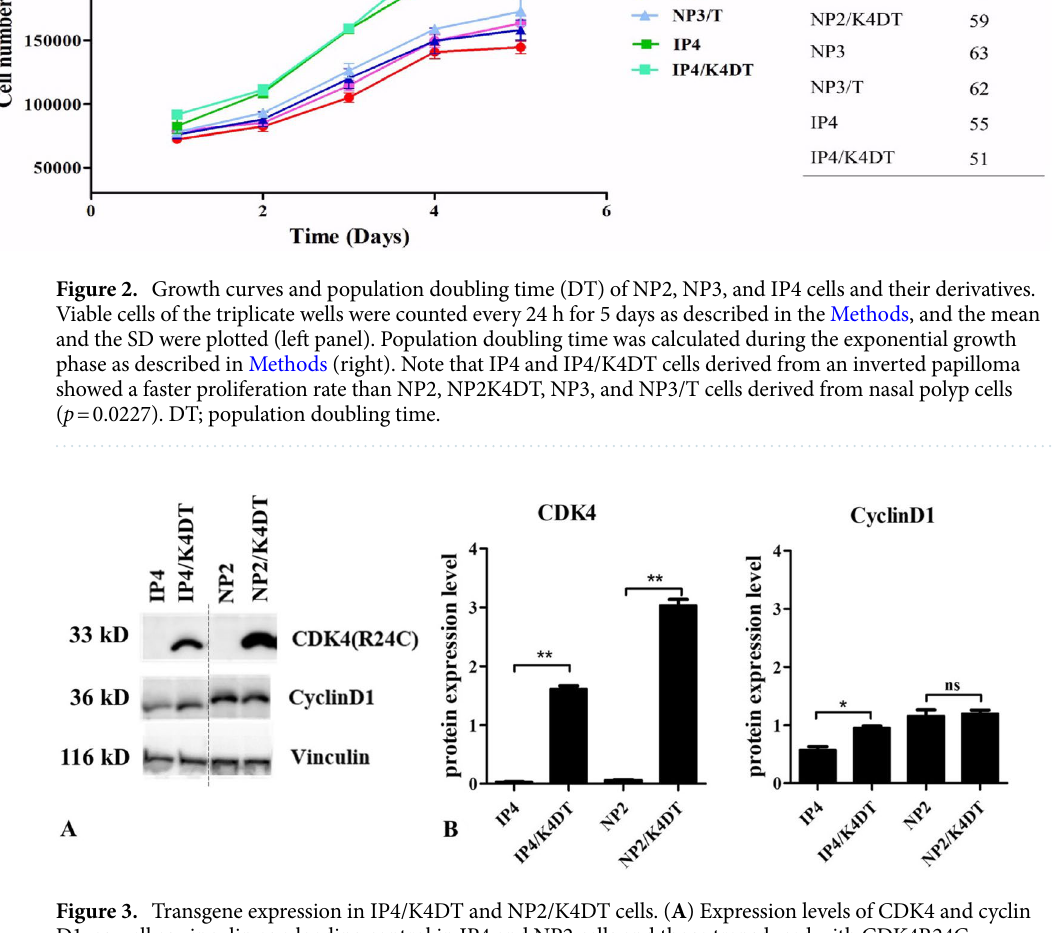
Figure 3. Transgene expression in IP4/K4DT and NP2/K4DT cells. ( A ) Expression levels of CDK4 and cyclin D1, as well as vinculin as a loading control in IP4 and NP2 cells and those transduced with CDK4R24C, cyclin D1, and TERT were examined in triplicate by western blotting. ( B ) Band intensities of CDK4 and cyclin D1 (normalized against those of vinculin) were quantified and indicated as bar graphs. Asterisks indicate statistically significant differences (* p < 0.05; ** p < 0.01), and “ns” indicates not